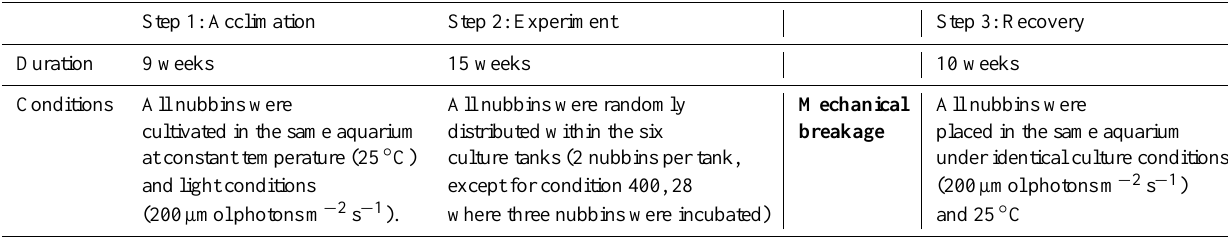
Table 1. Description of the three steps of the culture